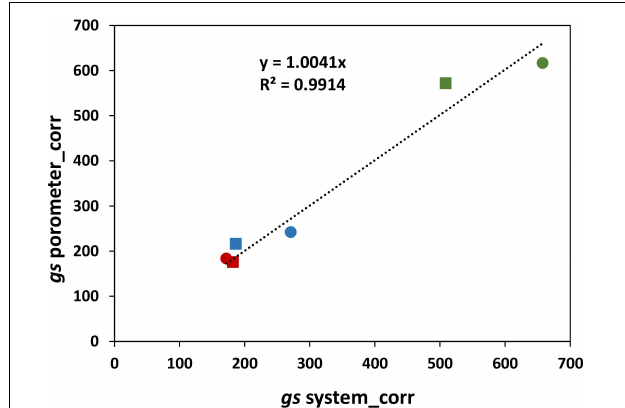
FIGURE 10 | Correlation between gs porometer measurements corrected for the abaxial and adaxial sides of the leaves ( gs porometer_corr ) and the gs from the system after correcting for the effect of the boundary layer resistance ( gs sysyem_corr